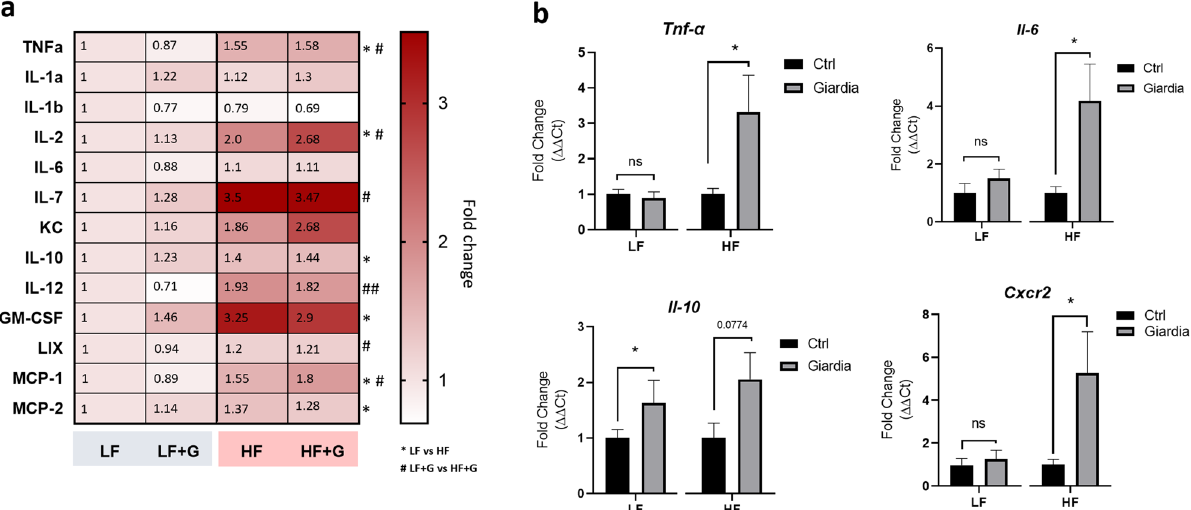
Figure 3. High fat diet exacerbates Giardia -induced low grade inflammation. ( a ) Multiplex analysis of jejunal tissue cytokines and chemokines assessed by Luminex Discovery Assay technology. The levels of 13 cytokines and chemokines were measured and represented as a heatmap. Data are represented as fold-change relative to uninfected low fat controls (range 0.5 to 3.25); n = 8–9/group. * p < 0.05 compared with LF control group; # p < 0.05 compared with LF + G group. ( b ) Jejunal mRNA levels of Tnf-α, Il-6, Il-10 and Cxcr2 were measured by Real-Time Quantitative Reverse Transcription-PCR and normalized to β-actin mRNA (2 -ΔΔCt method). Data are represented as fold change compared to LF and HF uninfected controls, respectively; n = 8–9/group. LF = low fat control mice; LF + G = low fat infected mice; HF = high fat mice; HF + G = high fat infected mice. Data are shown as mean ± S.E.M; * p <